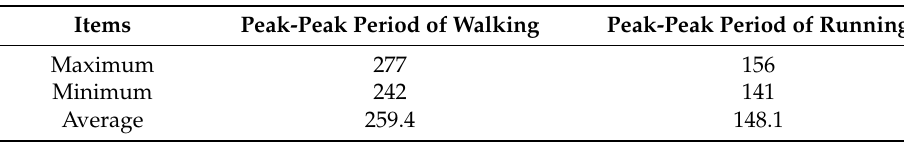
Table 1. Statistics of peak-peak time period of walking and running gait patterns.